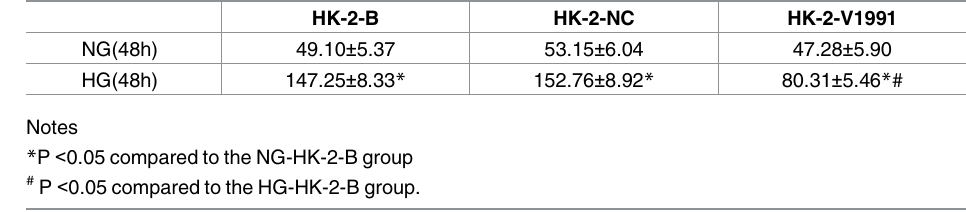
Table 3. Expression of FN in HK-2 cells as determined by ELISA ( x (cid:6) s , n =